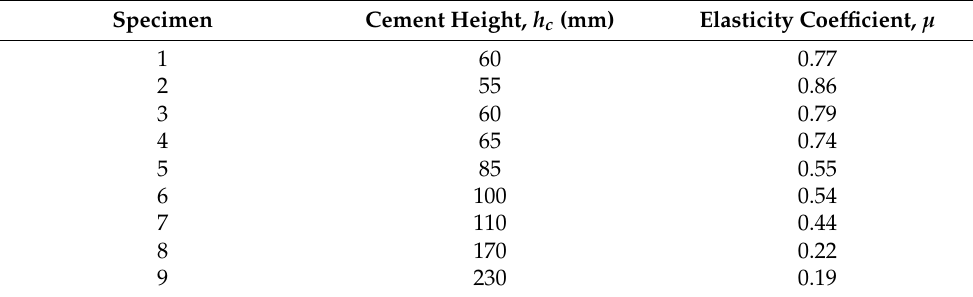
Table 3. Variation in the elasticity coefficient, µ , with the cement